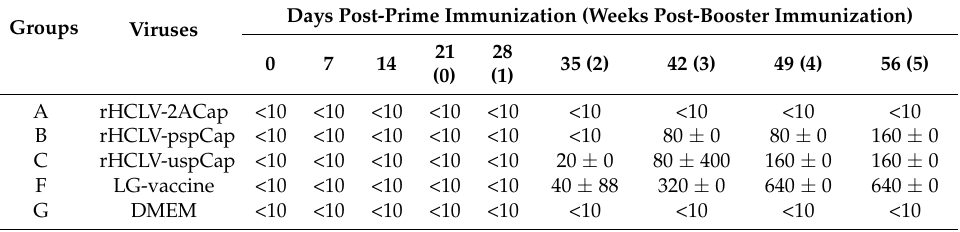
Table 5. Anti-PCV2 neutralizing antibody titers in the sera from the inoculated rabbits.